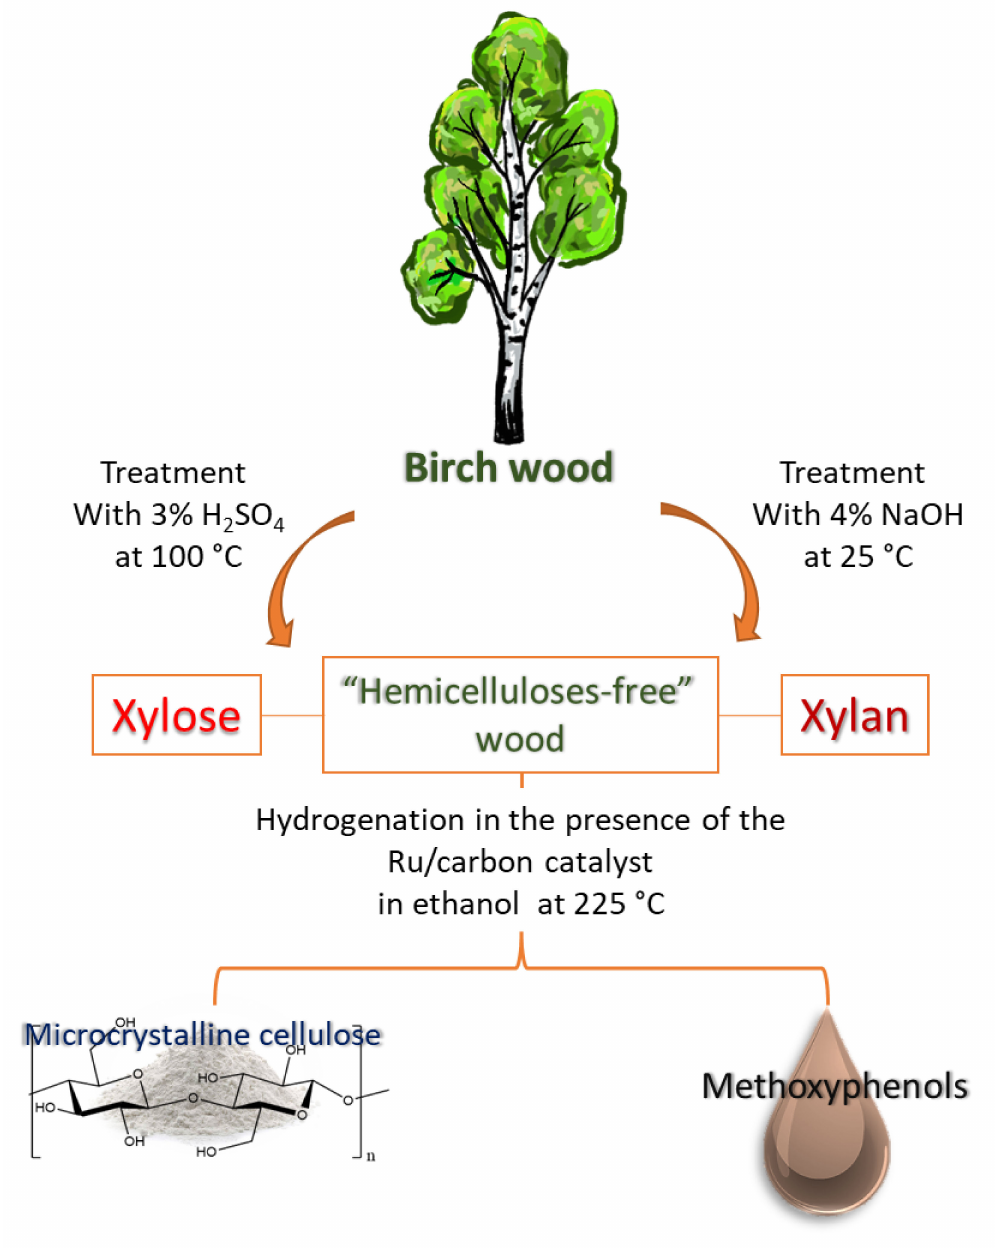
Figure 8. Scheme of complex processing of birch